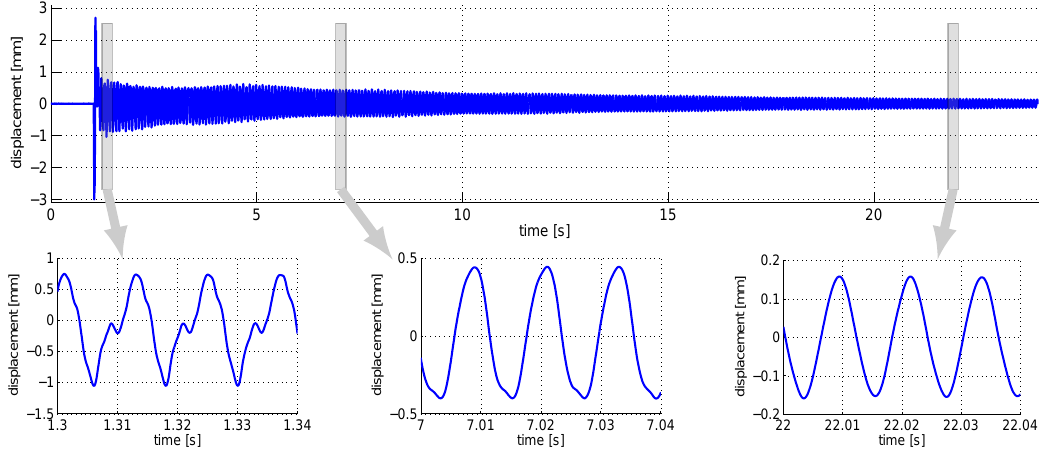
Figure 10. Recorded signals of the vibrating string.